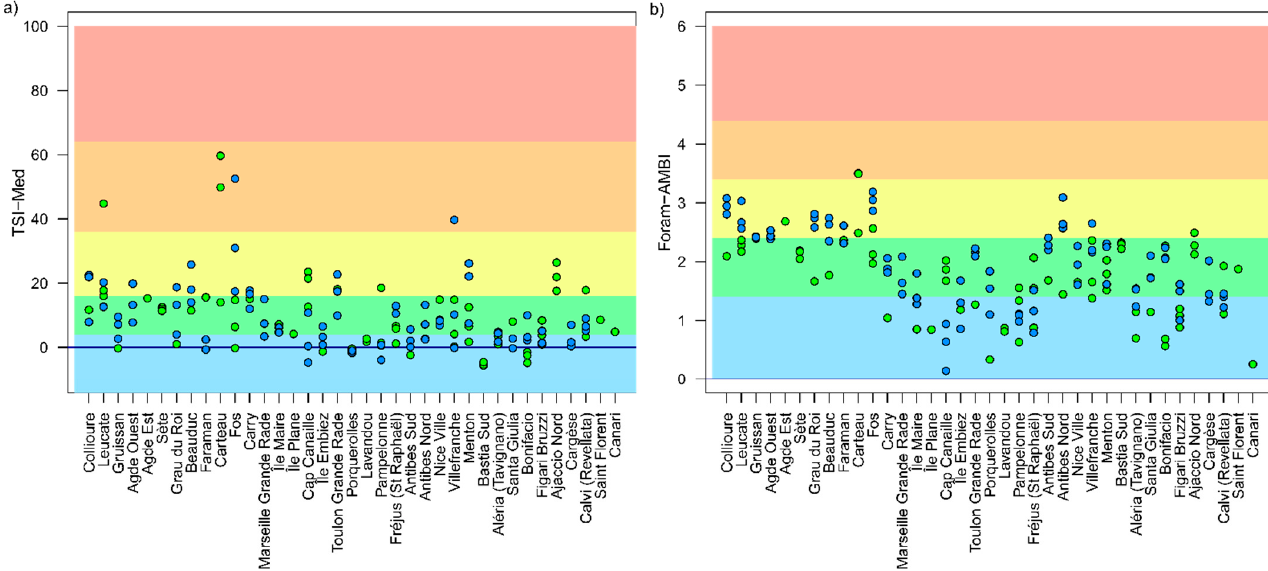
Figure 6. ( a ) TSI-Med and ( b ) Foram-AMBI values at each station. Both indices are calculated as they were described in their original descriptions. Green dots: sampled in 2012, and blues dots: sampled in 2015. EQS are represented by the coloured background: blue, “very good”; green, “good”; yellow, “moderate”; orange, “poor”; and red, “bad”. For the TSI-Med, EQS classes limits are from Barras and Jorissen [53], and for Foram-AMBI they are proposed in this study.